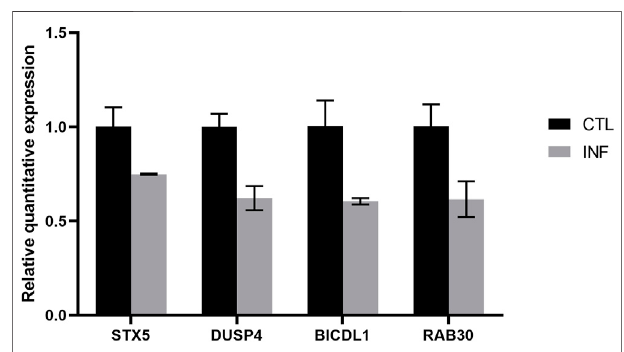
FIGURE 6 | Veri fi cation of dysregulated genes identi fi ed in the microarray experiment.